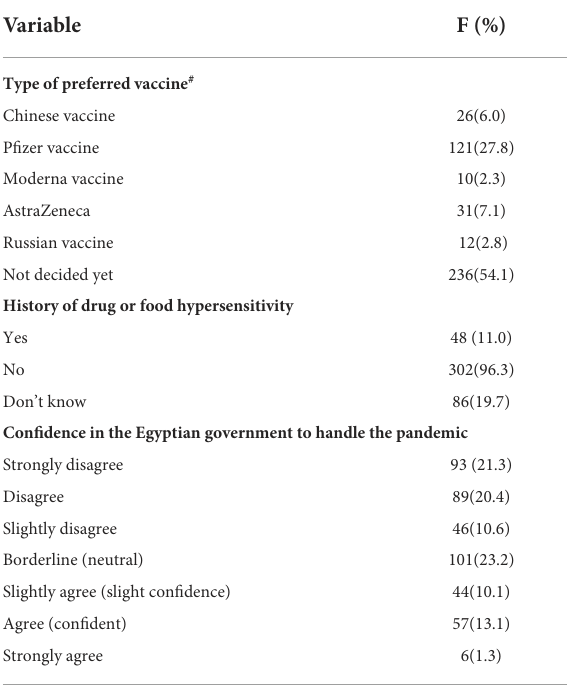
TABLE 3 The vaccine uptake; Intentions, Preference, and other related determinants among the studied physicians ( n = 436). Variable F (%)